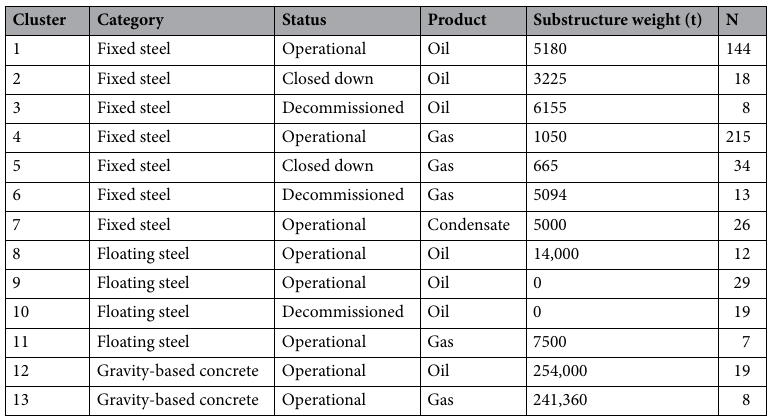
Table 1. Characteristics of the medoids of 13 clusters classifying the 552 oil and gas structures in the North Sea. Note, these are akin to the median of the cluster—not all individuals in a cluster will share identical values across all